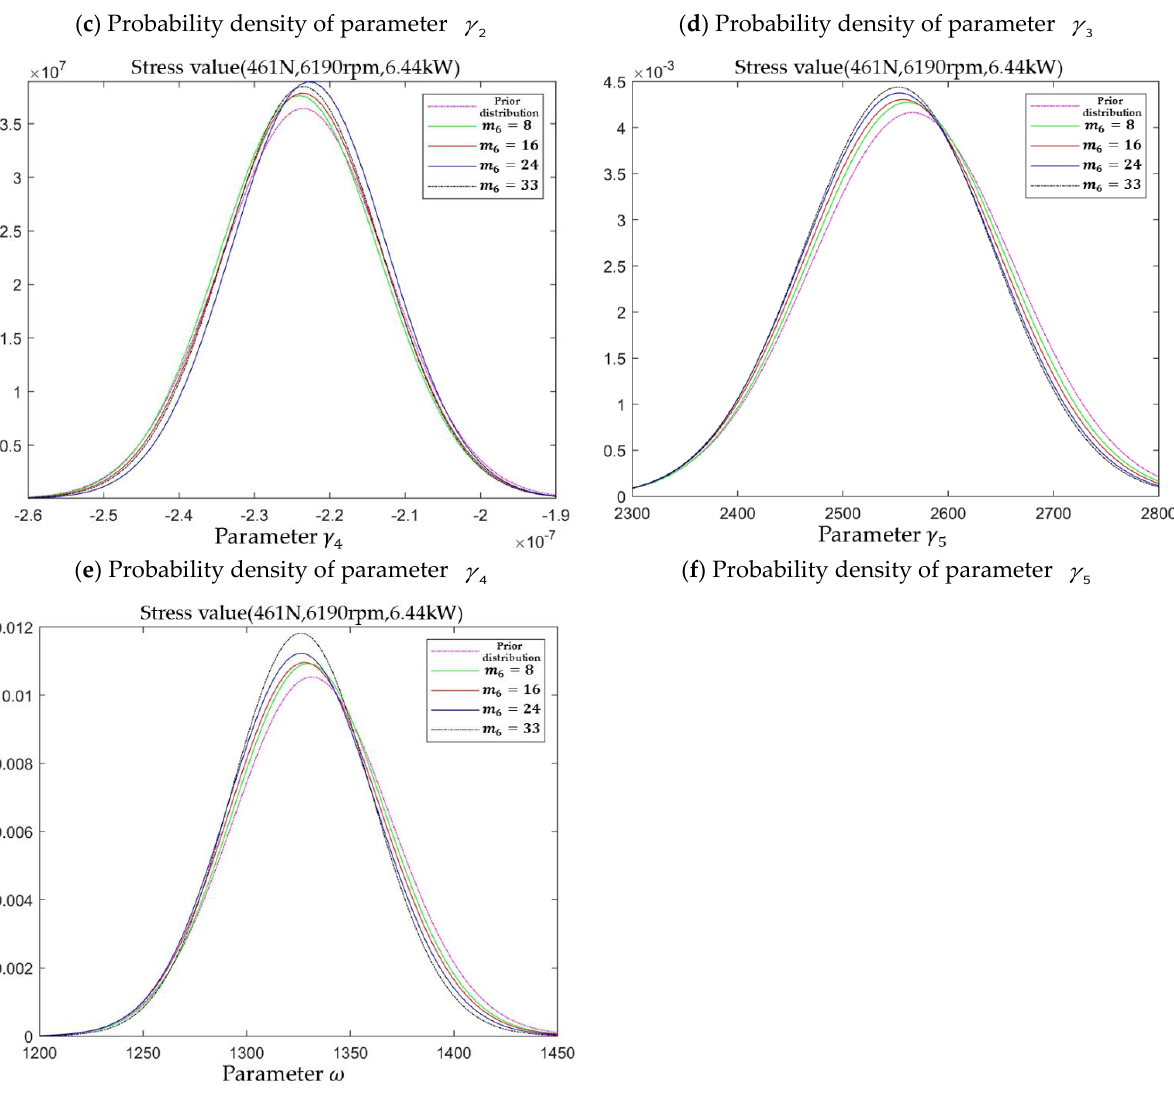
y  . The updated posterior distri- 5